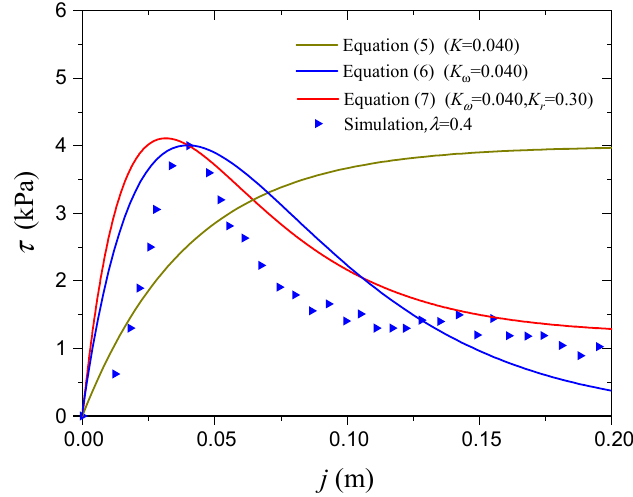
Figure 8. Classical “shear stress–displacement” relationship fitting DEM data.